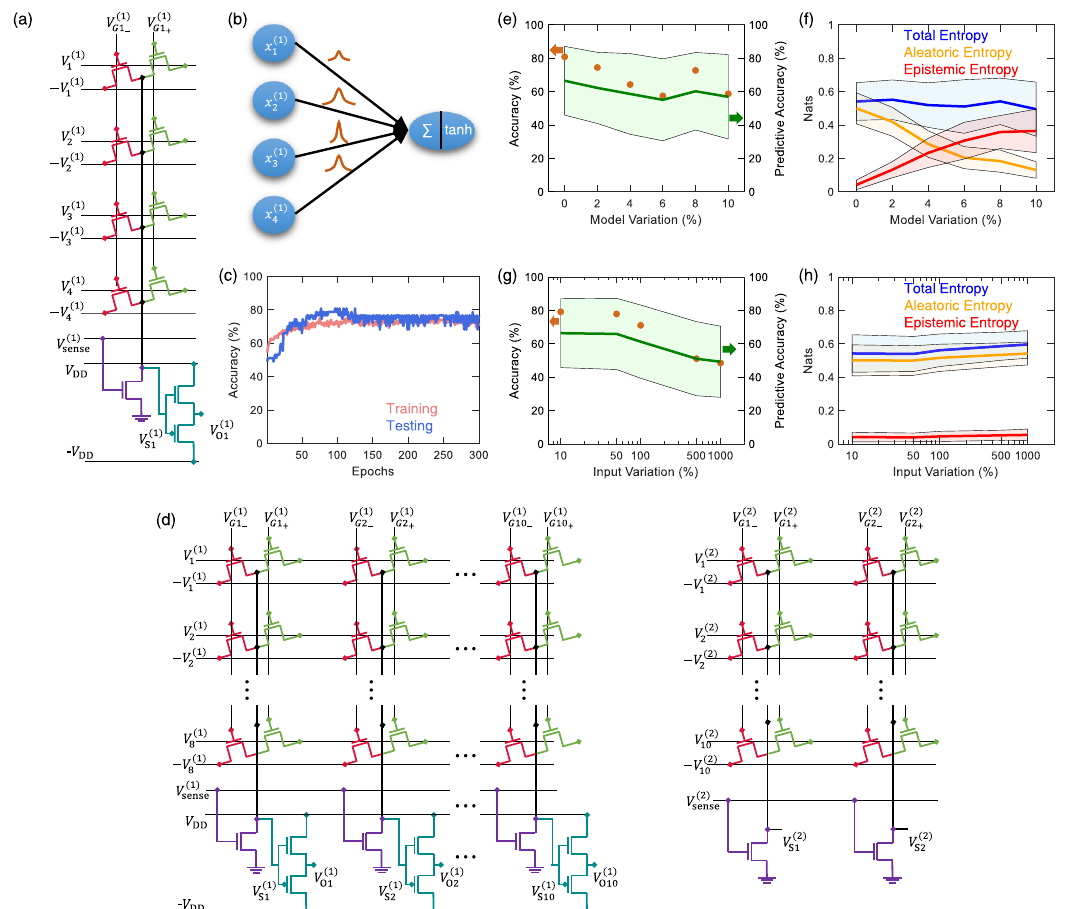
Fig. 5 | Crossbar array architecture to implement the BNN. a Schematic of a portion of a BNN, where multiple input neurons are connected to one output neuron through multiple synapses. b The corresponding circuit implementation using the crossbar array architecture. Here, a sense transistor is used to obtain a voltage ( V ð k Þ S j ) proportional to the dot product between the inputs ( V ð k Þ i ) and synapticdistributions( G ð k Þ ij ),where i , j ,and k representstherow,column,andlayer, respectively. V ð k Þ S j isappliedtothetanhactivationcircuittoobtaintheoutput( V ð k Þ O j ). c Trainingandtestingcurvesfor300epochsoftheBNNconstructedtoclassifythe